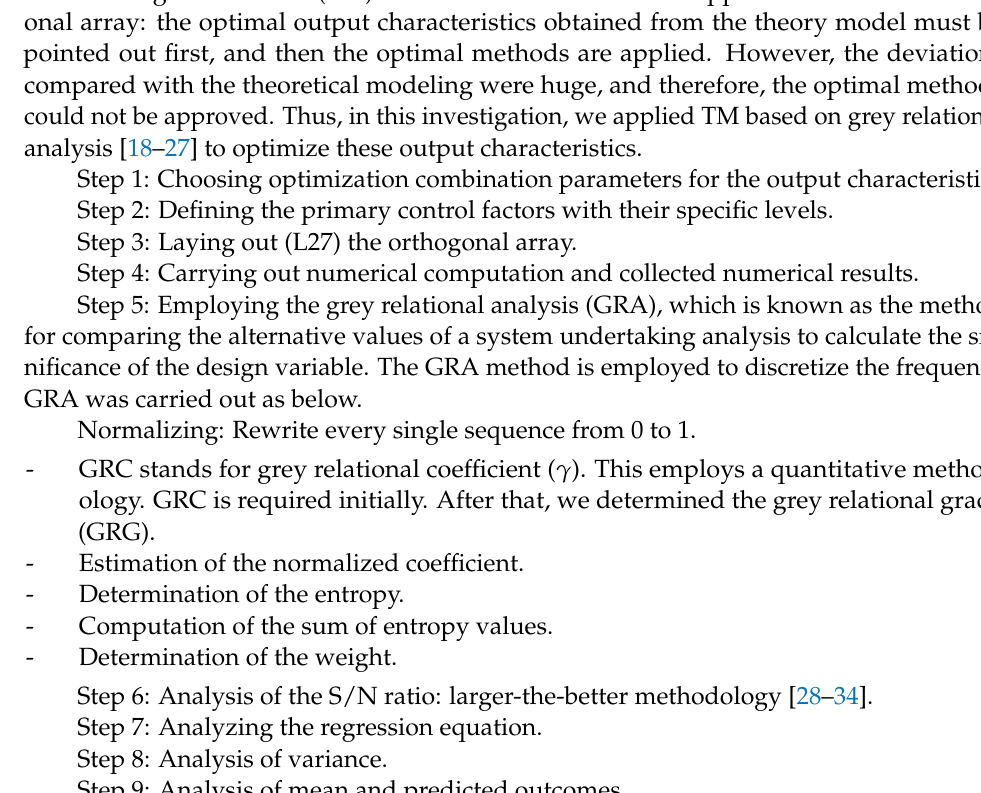
Figure 2. ( a ) Modeling meshes, and ( b ) locations of input displacements and fixed supports.